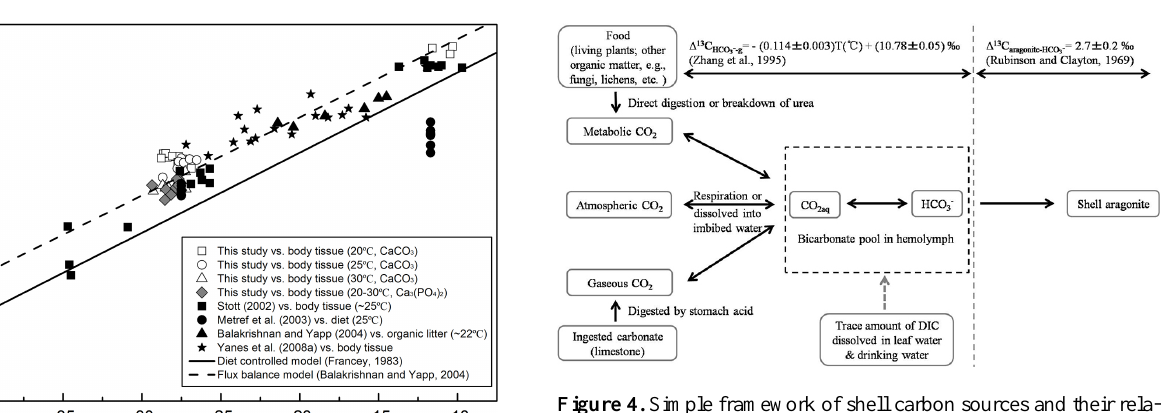
Figure 4. Simple framework of shell carbon sources and their rela- tive isotope fractionation processes based on this and earlier